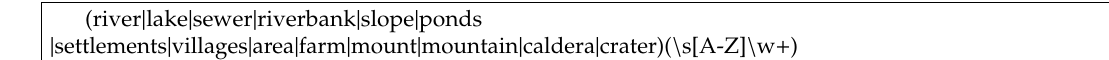
Box 1. Example regular expression for recognizing types of place names. Terms separated by | (or) are composed from semantic similarity from names of rivers, settlements, and mountains, respectively.